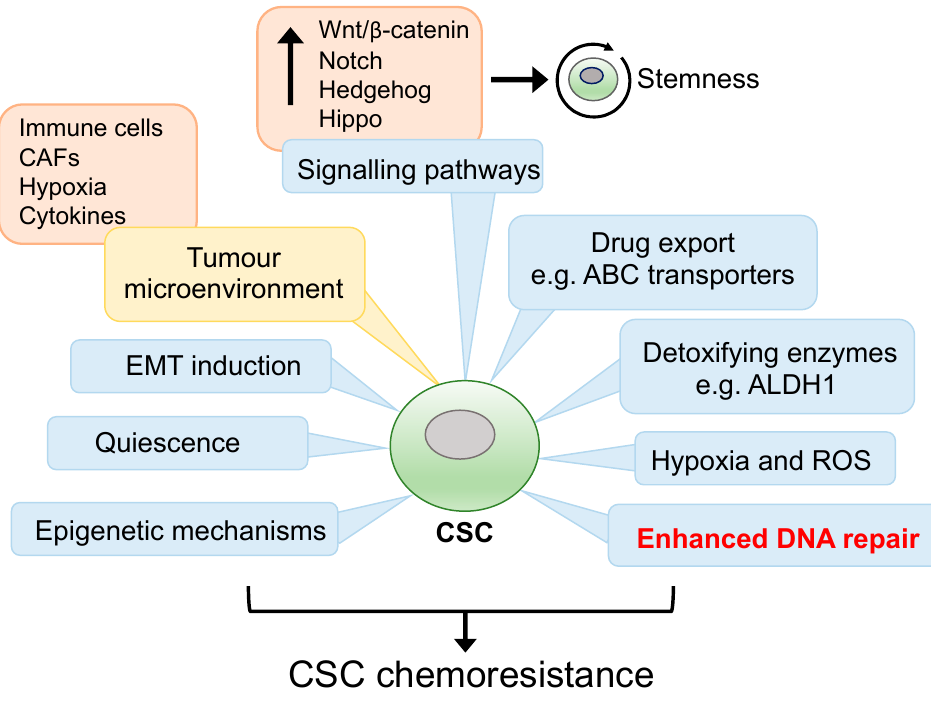
Figure 1. Mechanisms of drug resistance in CSCs. CSCs are endowed with multiple innate and adap- tive cell responses which enable them to survive stressful microenvironmental changes and cancer treatment. Enhanced DNA repair e ffi ciency in CSCs is thought to be a major contributing factor in counteracting treatment-induced DNA damage. Cell-autonomous mechanisms are in blue boxes and extrinsic in fl uences are in yellow boxes.